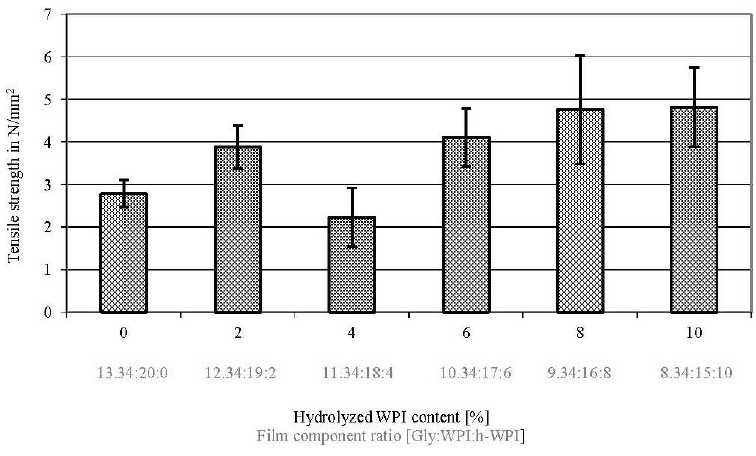
Figure 4. Effect of increased h-WPI content (reduced protein M content on the tensile strength values of WPI-based films.